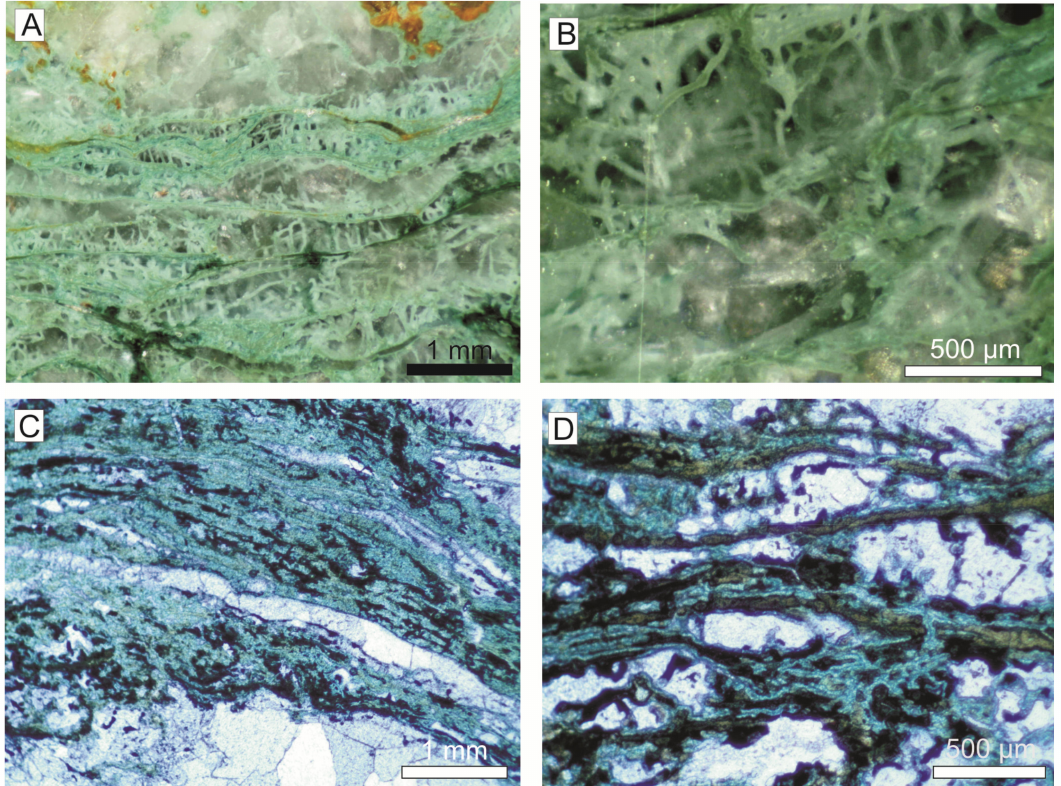
Figure 18. Filament structures from green laminated crusts observed by magnifying glass on polished slabs ( A , B ) and petrographic microscopy on thin sections ( C , D ). ( A , B ) Transversal section of a green laminated crust surrounded by calcite with the presence of planar filamentous green laminae and perpendicular branching filaments. ( C , D ) Mesh of green filaments composing the lamination. Note that blue-green material corresponds to glauconitic micas (glauconite and celadonite) and dark green to black material corresponds to smectite